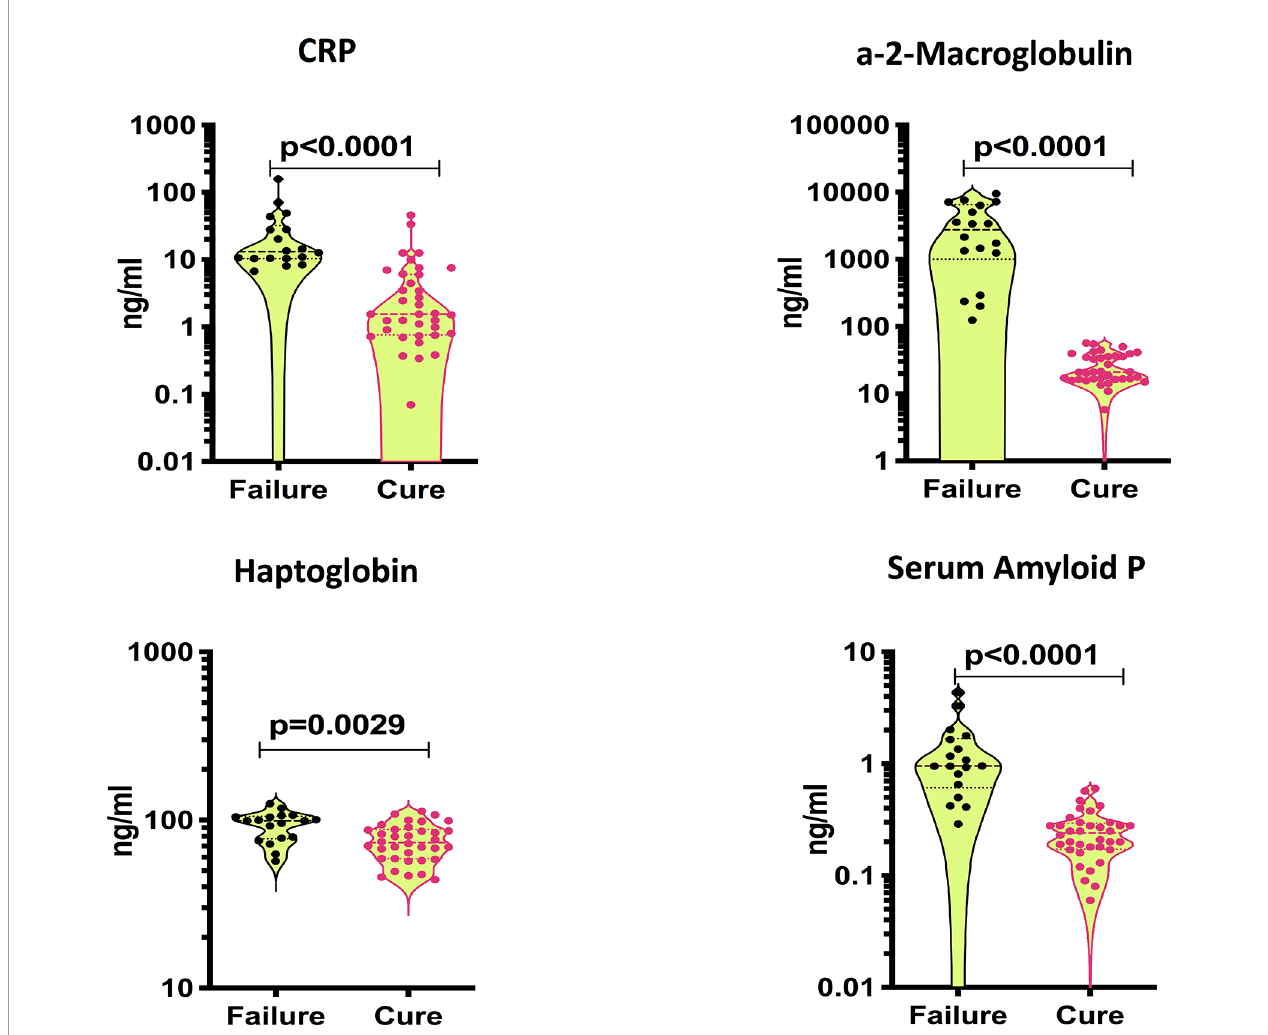
FIGURE 1 | Elevated baseline plasma levels of APPs in TB treatment failure. The baseline plasma levels of APPs were measured in failure (n=18) and cure (n=36). The data are represented as violin plots with each circle representing a single individual. P values were calculated using the Mann-Whitney test with Holm ’ s correction for multiple